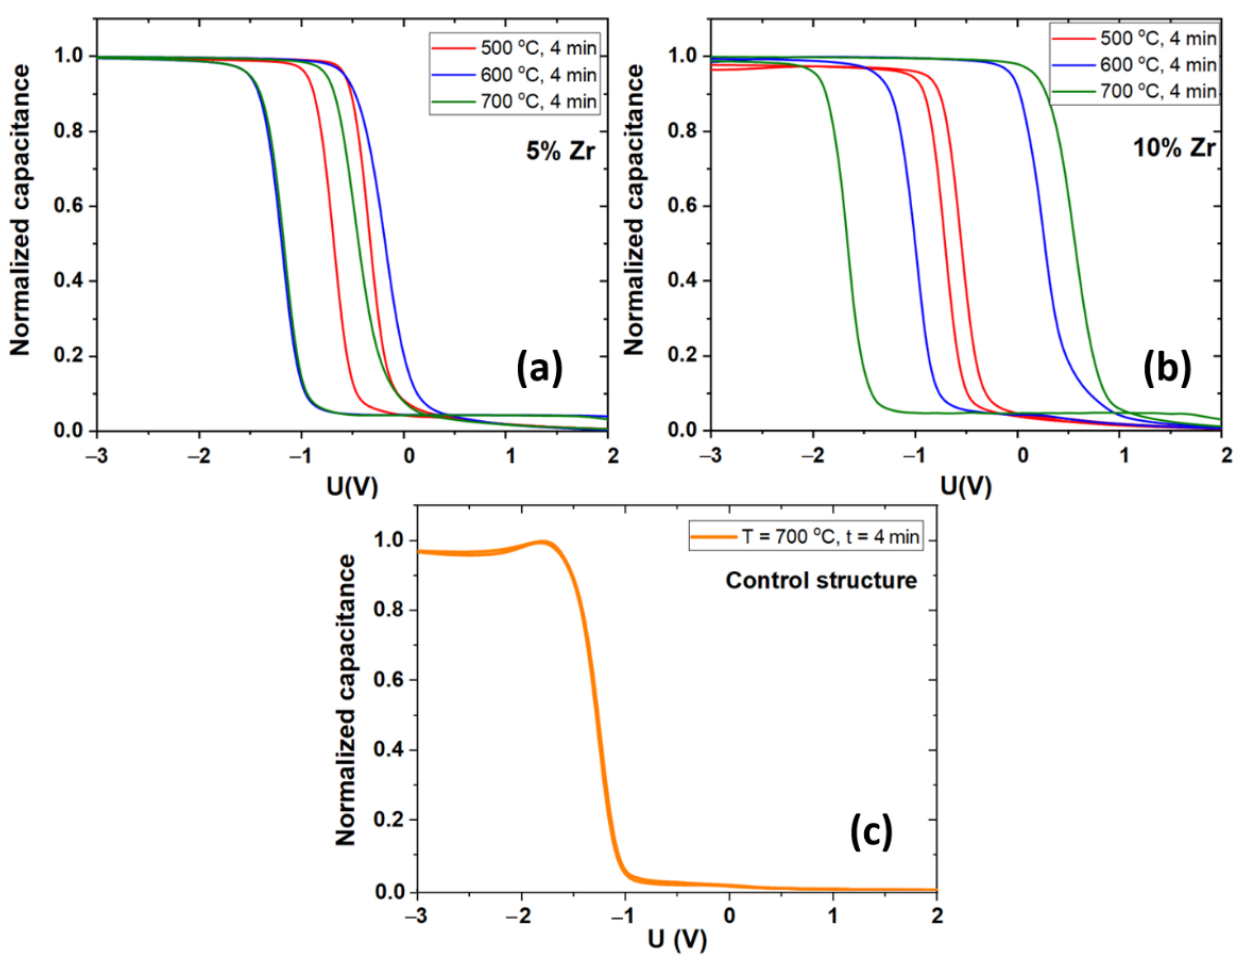
Figure 5. C – V characteristics obtained on the MOS-like capacitor with ( a ) 5% and ( b ) 10% concen- tration in the floating gate layer, annealed at 500°C, 600 °C, and 700 °C for 4 min; ( c ) C – V curves obtained on the control structure of 56 nm of ZrO 2 annealed at 700 °C for 4 min.